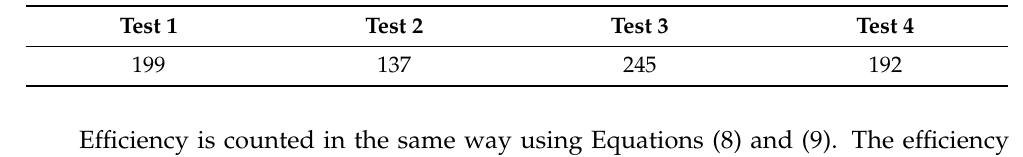
Table 7. Example 2: Results from four tests for the cycle list model.